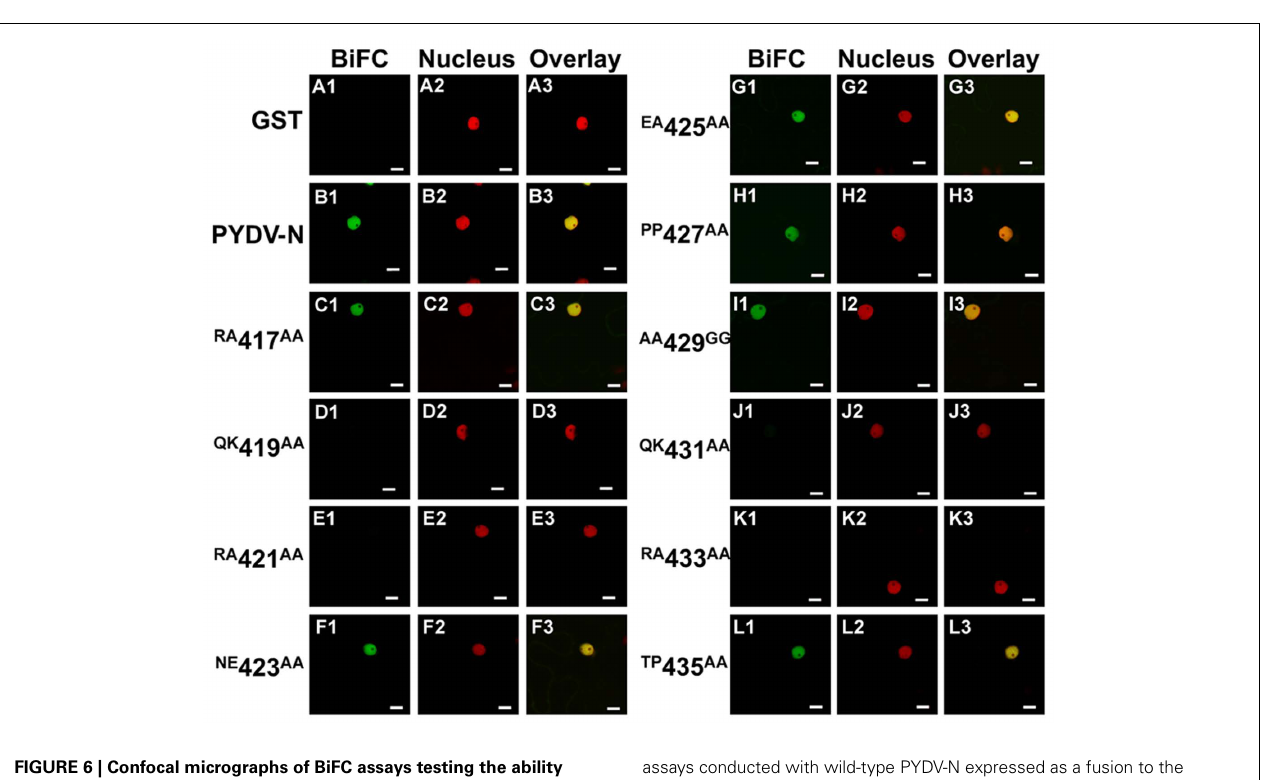
FIGURE 6 | Confocal micrographs of BiFC assays testing the ability of PYDV-N mutant proteins to associate with the wild-type N protein. Interaction assays were conducted in leaf epidermal cells of transgenic N. benthamiana expressing a fluorescent nuclear marker (Nucleus). Panels 1, 2, and 3 show micrographs ofYFP (BiFC), nuclear marker, and the resultant overlay, respectively. Shown here are BiFC